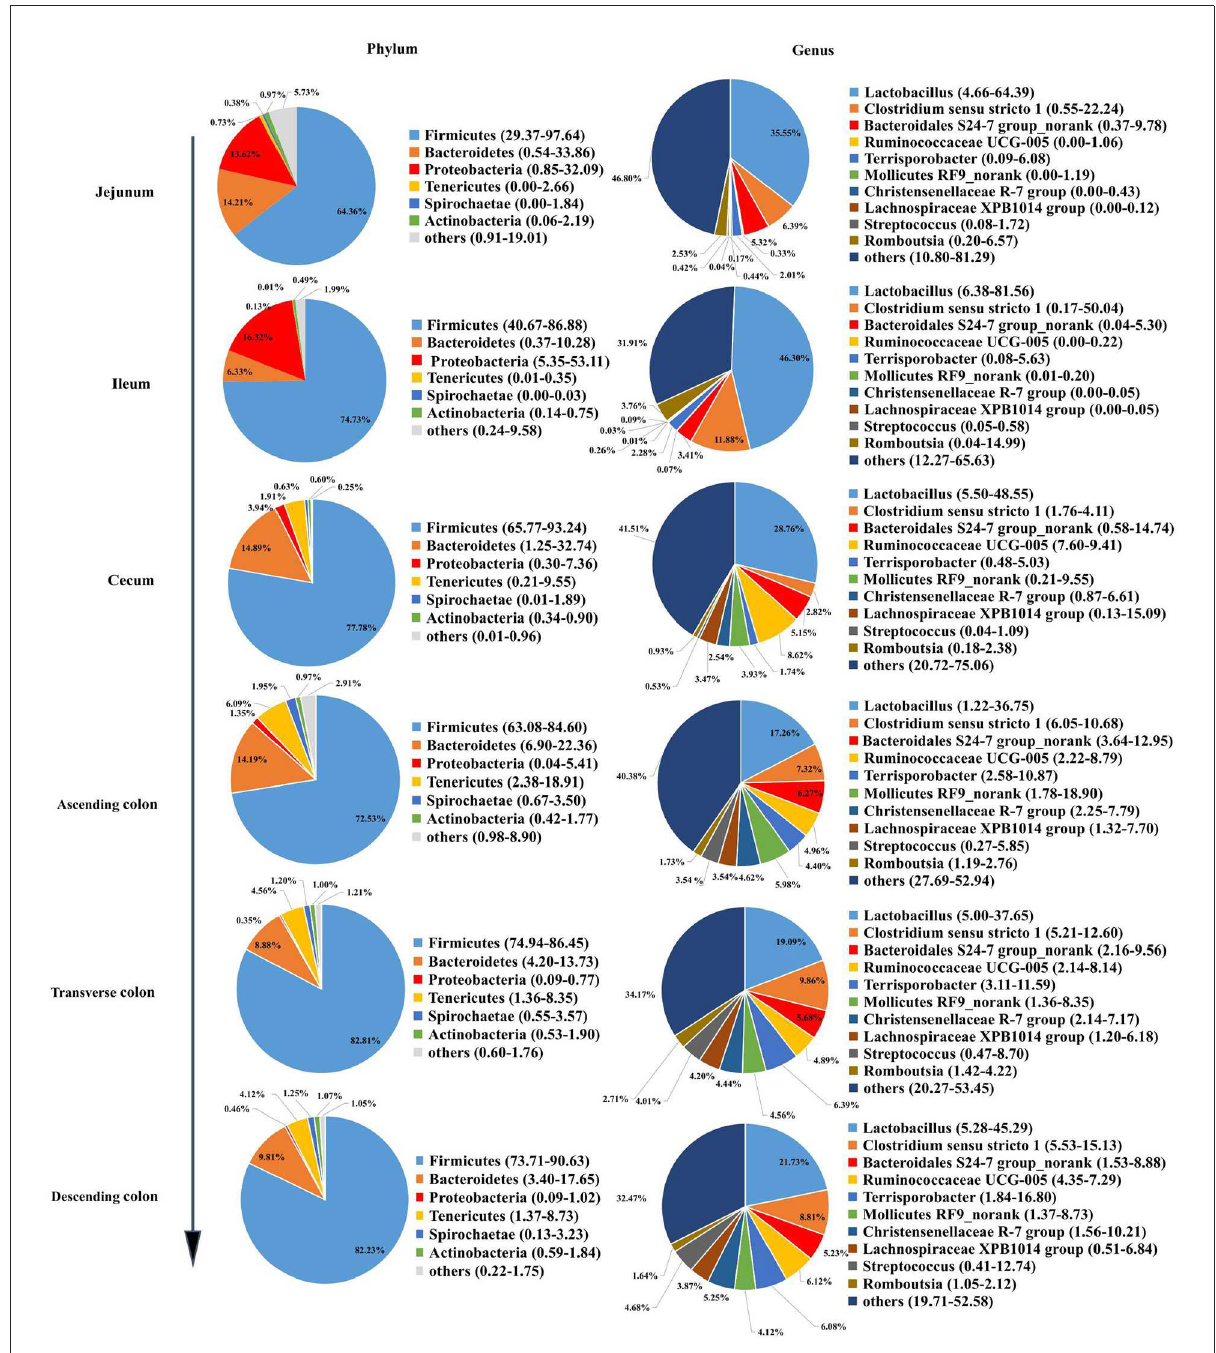
FIGURE2 Microbial community structure in different intestinal locations of pigs at the phylum and genus